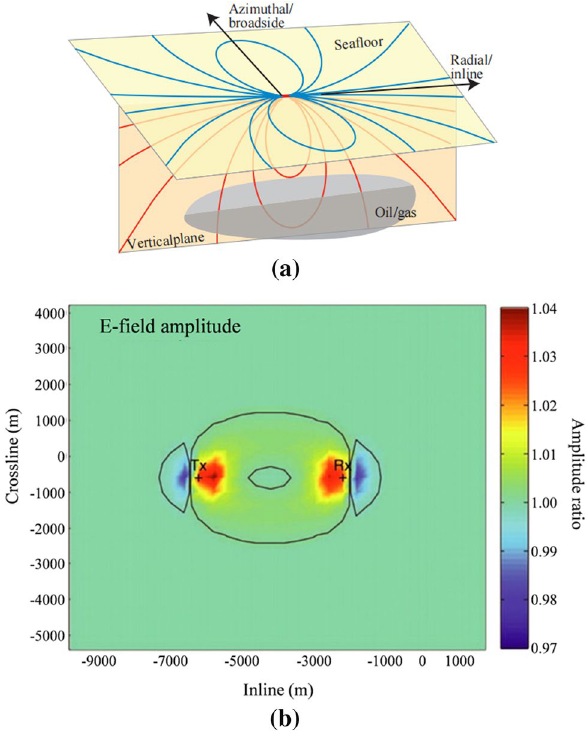
Fig. 10 Electrical exploration a Working principle (i.e. the dipole geometry of a near-seafloor transmitter, here the maximum vertical electric fields (red) are below the transmitter in the inline direction, and fields are of purely radial geometry and able to generate galvanic effects when they intersect subhorizontal, tabular bodies such as oil and gas reservoirs (Constable 2010)) and b Example output (Consta- ble 2010), where Tx and Rx represent transmit and receive, respec-